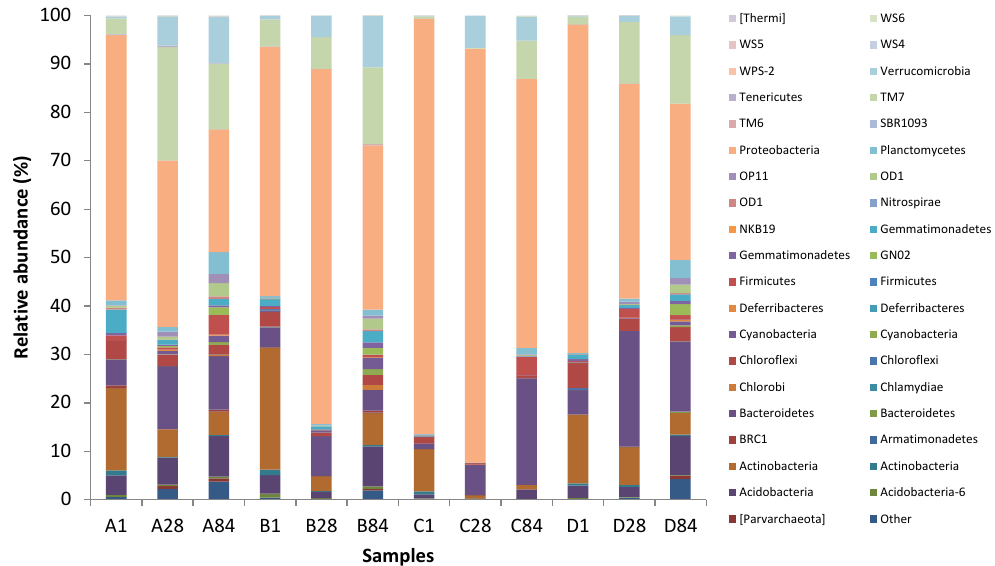
Figure 5. Relative abundance of different phyla in bioremediated soil samples (A, B, C, D – names of the variant, as in Fig. 2; 1, 28, 84 – days of sampling). Table 2. Alpha biodiversity indexes and 16S rDNA copy number in bioremediated soil samples.